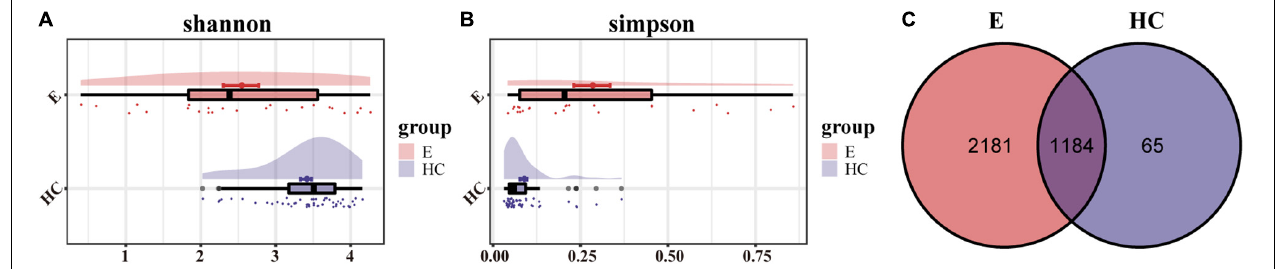
FIGURE 2 | α -Diversity in the fecal microbiota of Eps ( n = 24) and HCs ( n = 50). (A) The Shannon index was higher in HCs, indicating that the α -diversity of HCs was higher. (B) The higher the Simpson index is, the lower the microbial diversity. Therefore, the Eps had a lower diversity than the HCs. (C) The Venn diagram displaying overlap between the two groups showed that 1184 of the 3430 OTUs were shared between the Eps and HCs (blue). A total of 2181 of the 3430 OTUs were unique to Eps. Eps, patients with epilepsy; HCs, healthy controls; OTUs, operational taxonomic units.